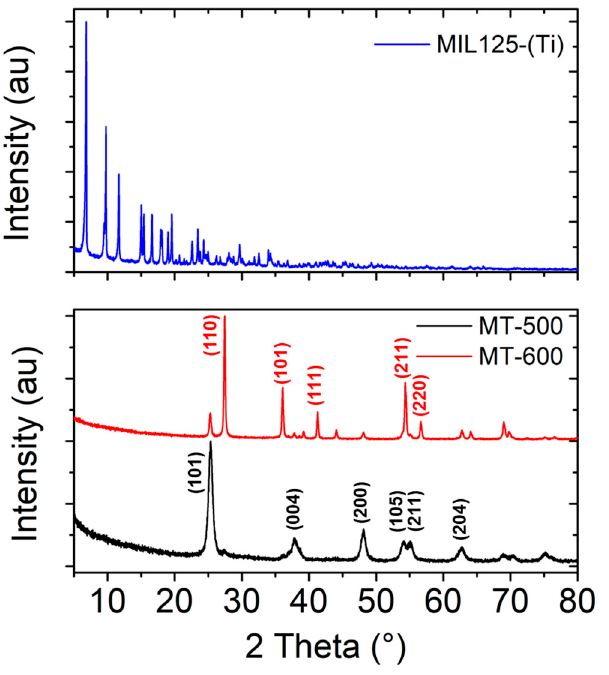
Figure 4. ( Top ) panel: XRD pattern of MIL125 ‐ (Ti); ( Bottom ) panel: XRD patterns of MT ‐ 500 and MT ‐ 600.